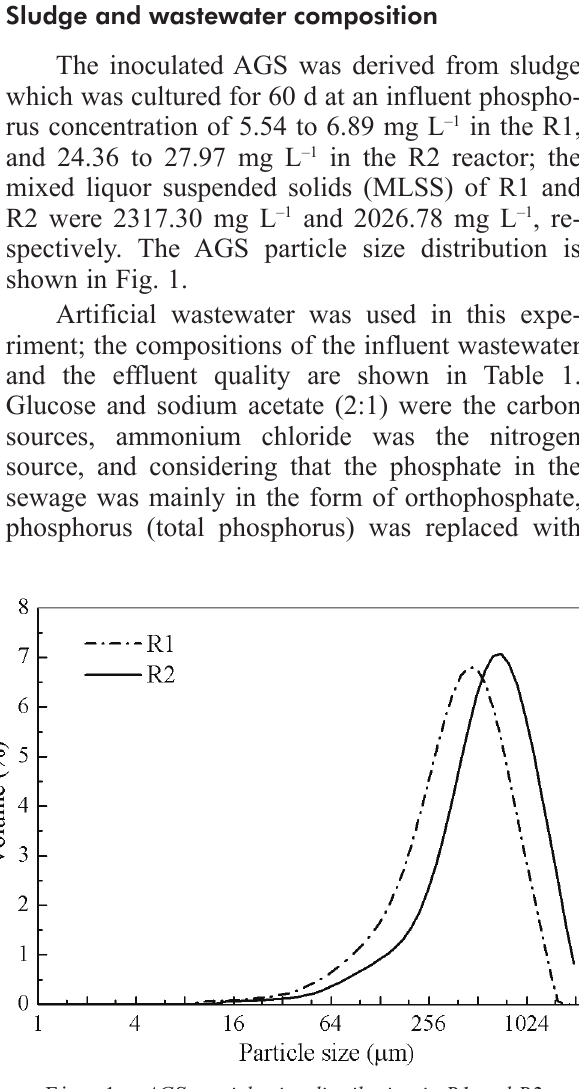
Fig. 1 – AGS particle size distribution in R1 and